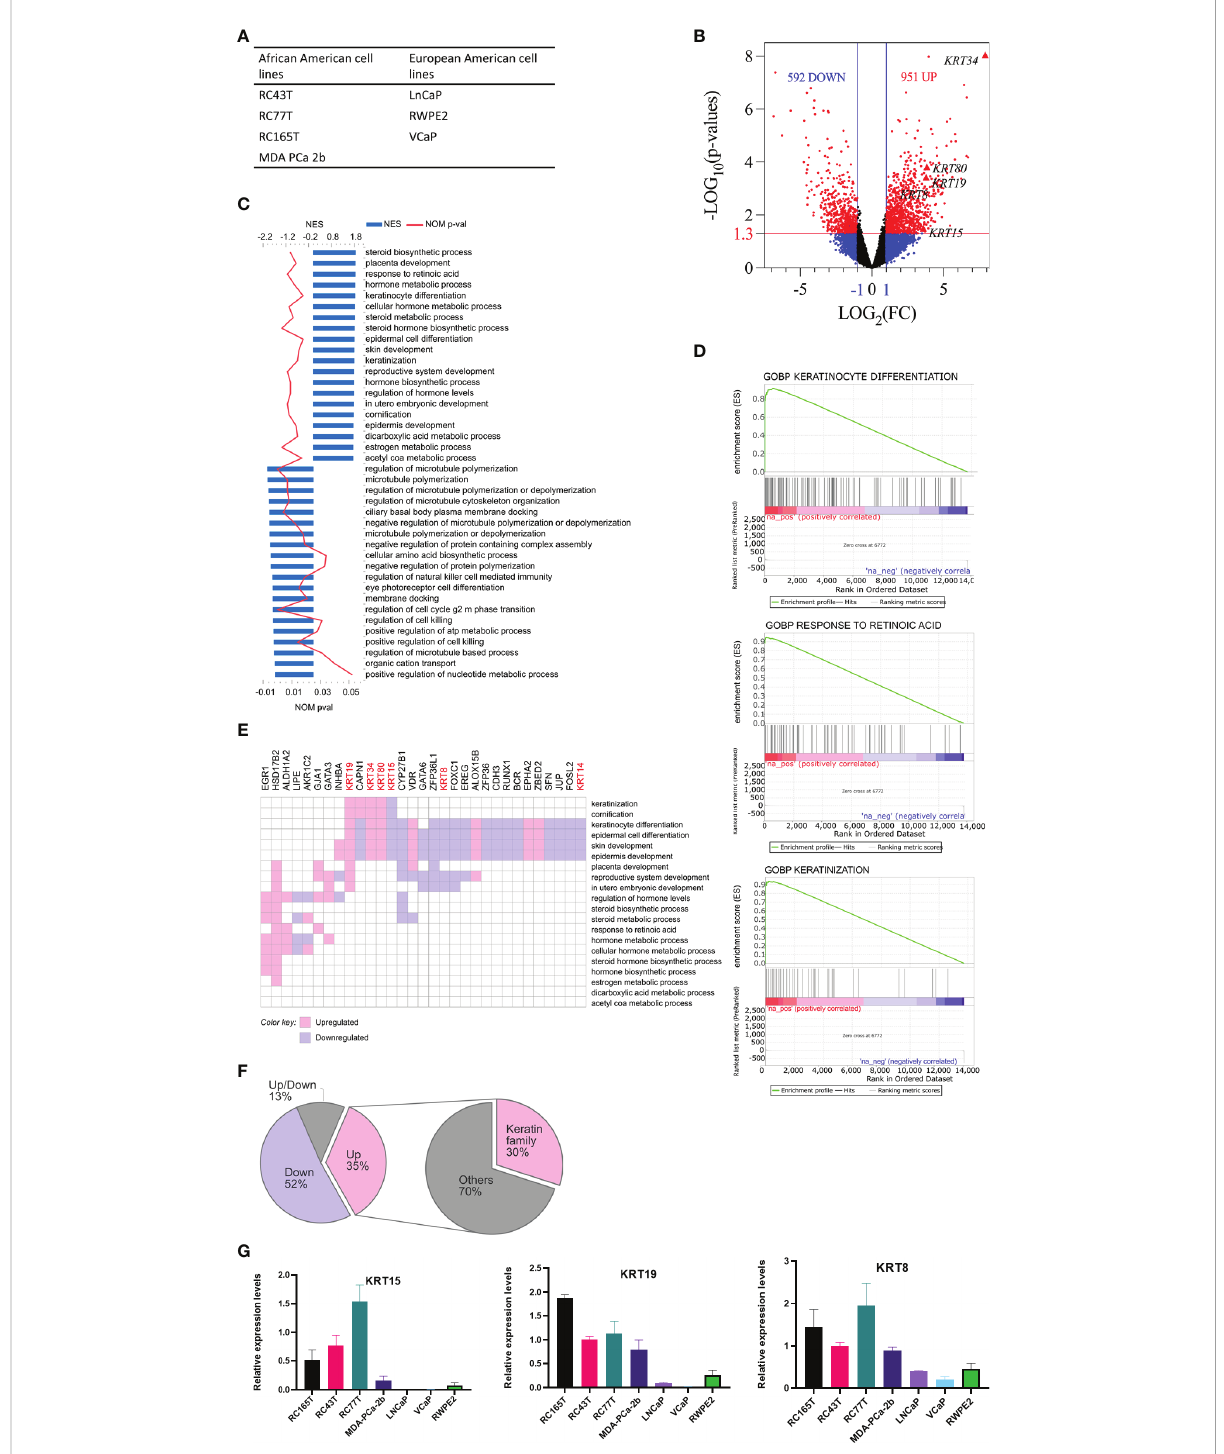
FIGURE 1 Analysis of differentially expressed genes (DEG) between AA and EA PCa cell lines. (A) AA and EA PCa cell lines. (B) volcano plots of DEGs; genes were differentially expressed if FC ≥ 2 (LOG 2 (FC) ≥ 1) and p ≤ 0.05 (-LOG 10 P = 1.3). (C) GOBP (gene ontology biological processes) gene sets enriched in AA PCa cell lines relative to EA PCa cell lines. (D) representative gene set enrichment plots. (E) leading-edge genes in top 20 positively enriched gene sets. (F) proportions of leading-edge genes; the keratin family of genes constituted the single most prominent family of DEGs enriched in AA. (G) Validation of RNA-seq data by RT-qPCR. The expression of selected DEGs in cancer cell lines quanti fi ed by qRT-PCR were